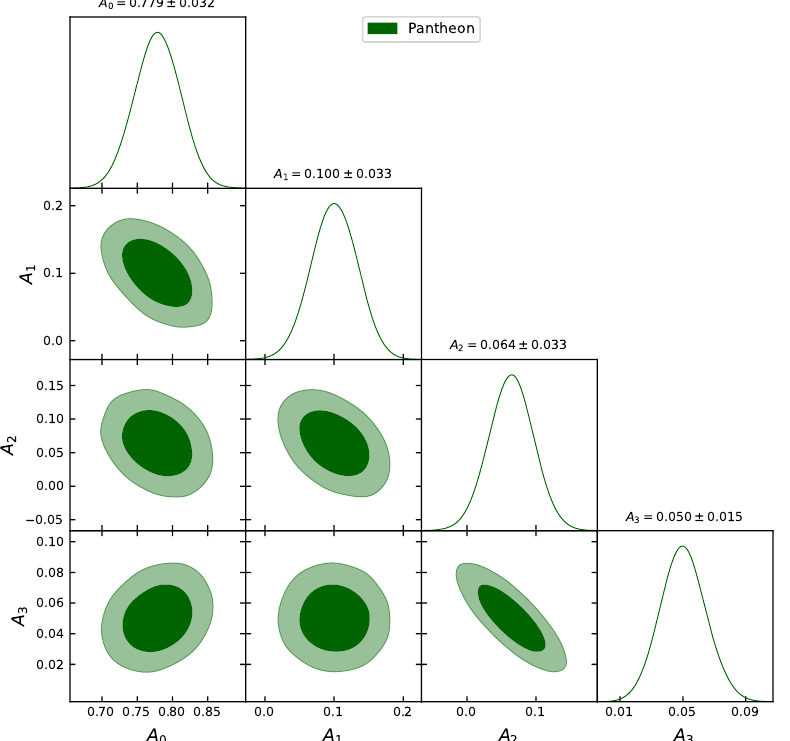
Figure 4. The marginalized constraints on the coefficients in the expression of Hubble parameter H ( z ) in Equation (26) are shown by using the Pantheon SNe Ia